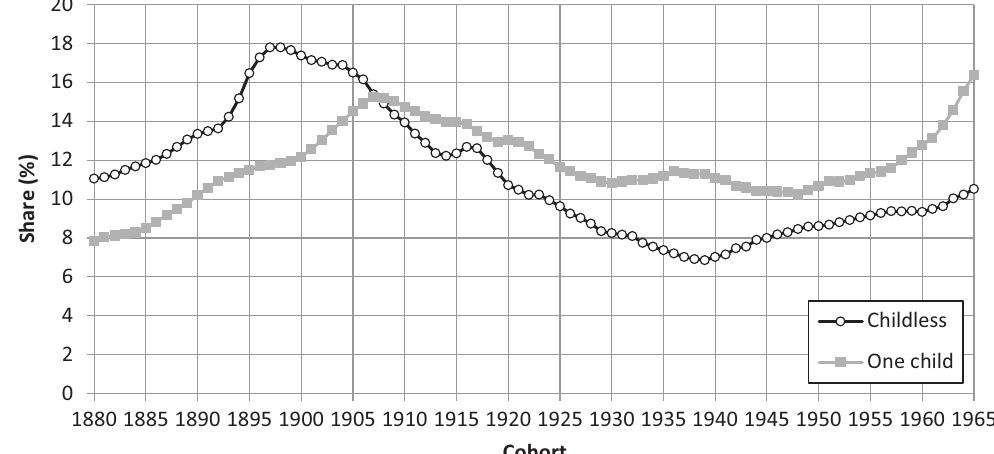
Figure 1. The proportion of childless women and women with one child in Slovakia: 1880–1965 cohorts. Source: Author’s calculations based on Statistical Office of the Slovak Republic